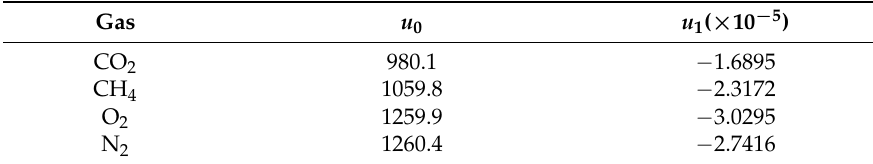
Table 3. Constants for the calculation of gas–water interaction-energy parameters in the temperature range 273–348K.